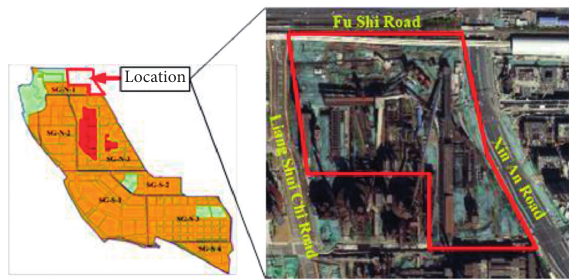
Figure 4: Plot of the